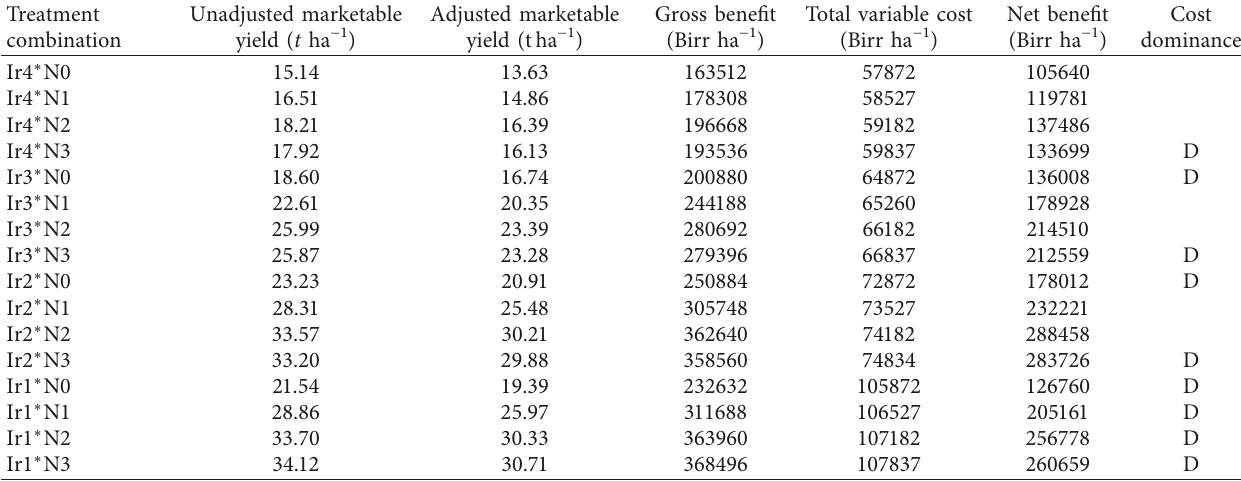
Table 8: Partial budget analysis in respect of irrigation and fertilizer N levels on marketable yield of onion. Treatment Unadjusted marketable combination